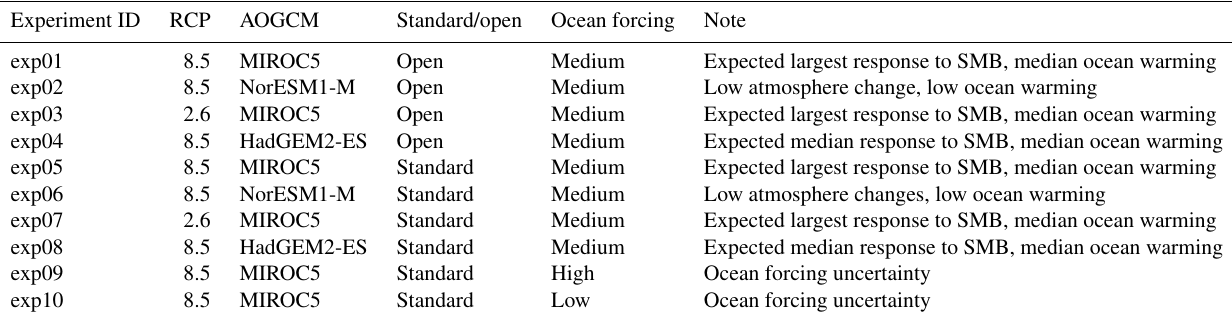
Table 3. Greenland core (Tier 1) experiments.